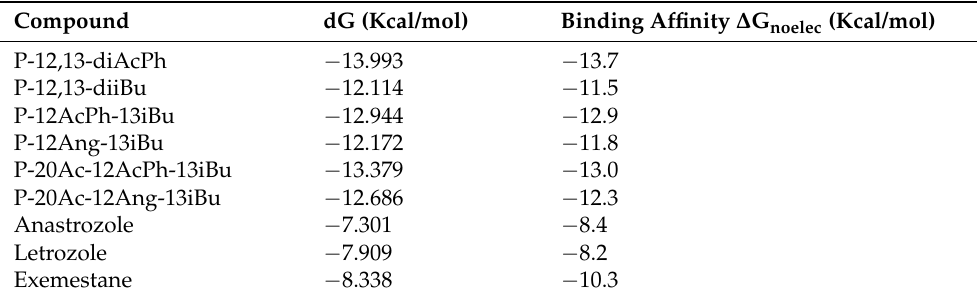
Table 1. Table showing the binding energy of the compounds and binding affinities of the docked